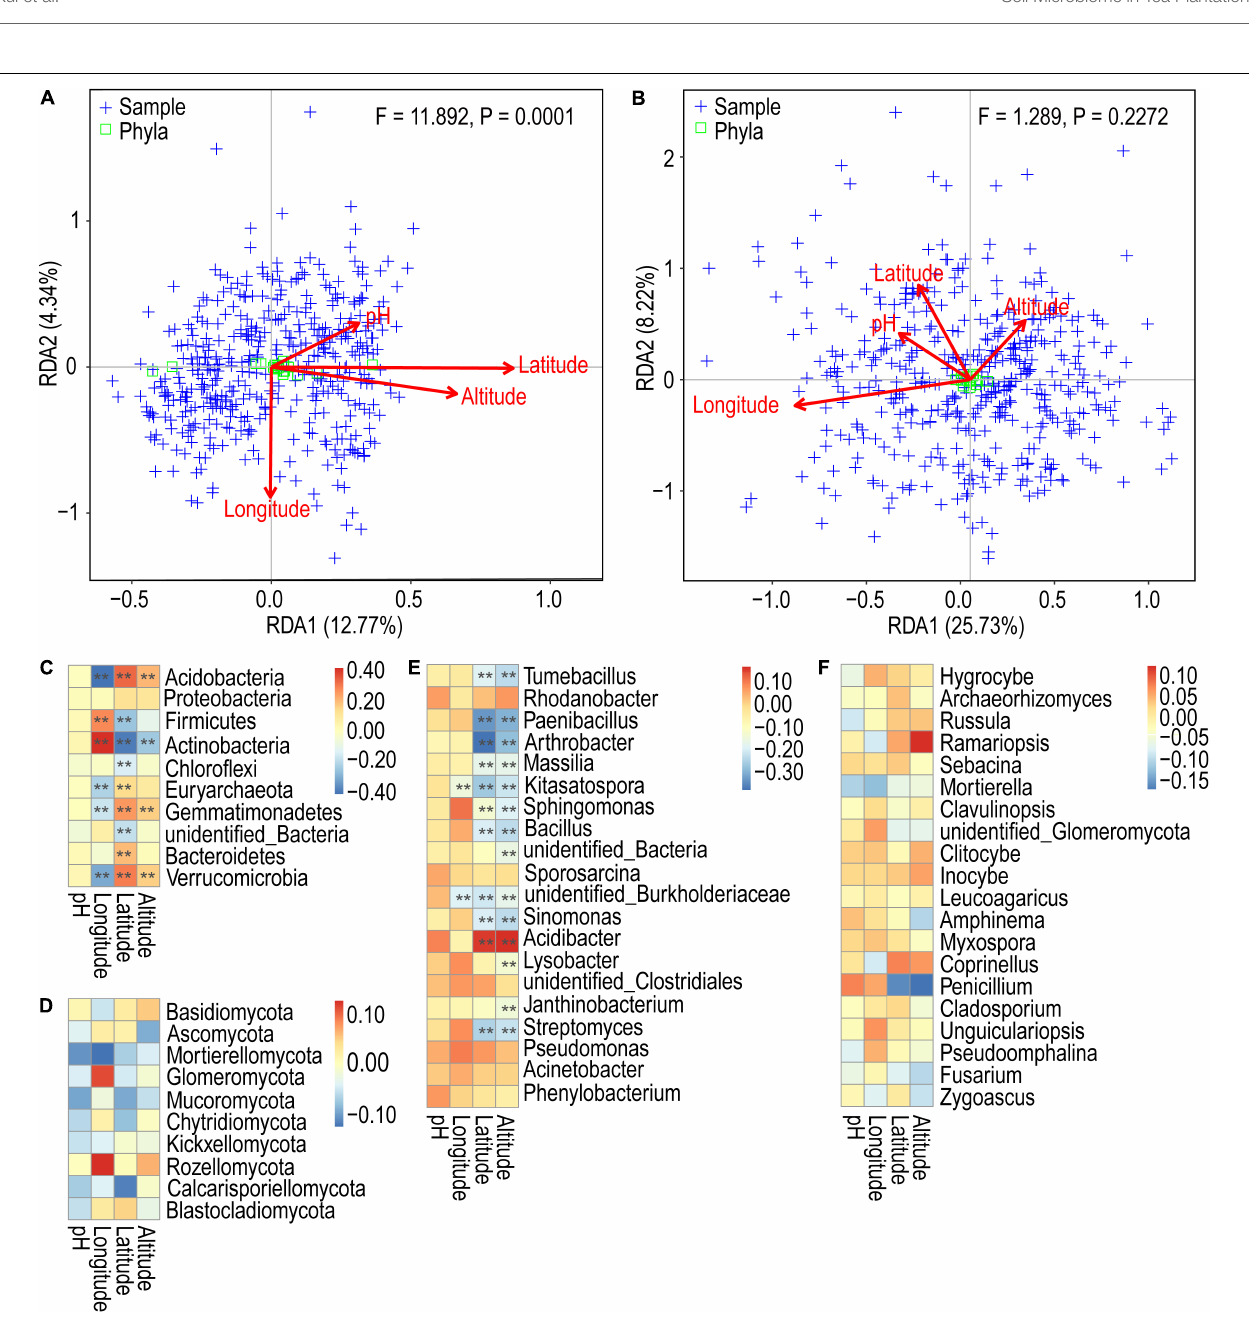
FIGURE 5 | Redundancy analysis of the composition of soil bacterial (A) and fungal (B) communities in tea plantations with environmental and geographical factors. Spearman’s correlation analysis between phylum/genus of relative abundance and environmental and geographical factors. (C) Bacterial phylum classification level; (D) fungal phylum classification level; (E) bacterial genus classification level; (F) fungal genus classification level. ** p <